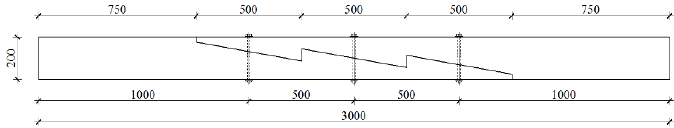
Figure 3. Sketch of a stop-splayed scarf joint (‘Bolt of lightning’) with dimensions of an actual element, Figure 3. S ketch of a stop-splayed scarf joint ( ‘ Bolt of lightning ’ ) with dimensions of an actual Figure 3. S ketch of a stop-splayed scarf joint ( ‘ Bolt of lightning ’ ) with dimensions of an actual Figure 3. S ketch of a stop-splayed scarf joint ( ‘ Bolt of lightning ’ ) with dimensions of an actual drawing based on data from [11]. element, drawing based on data from [11]. element, drawing based on data from [11]. element, drawing based on data from [11].